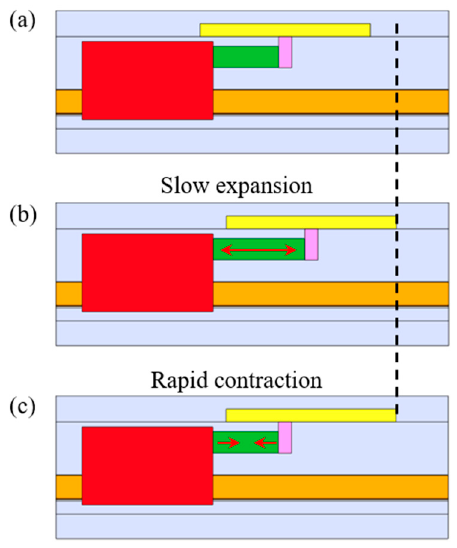
Figure 5. The smooth impact drive mechanism (SIDM) mode for positioning the slider 2. ( a ) Initial position of the PZT; ( b ) Slow expansion of the PZT; ( c ) Rapid contraction of the PZT.